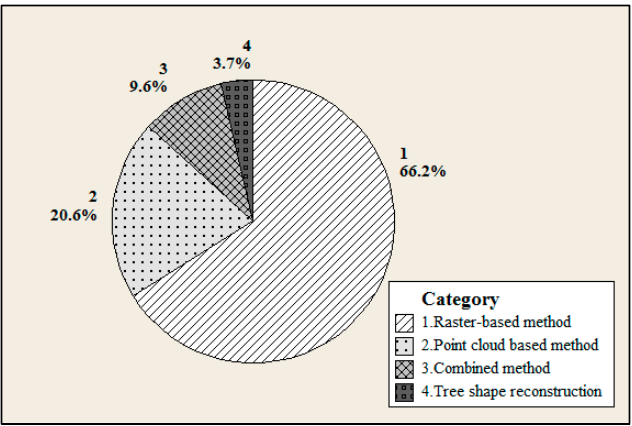
Figure 3. Summary of ITCD methods using LiDAR data in ITCD and related literature ( N = 136).